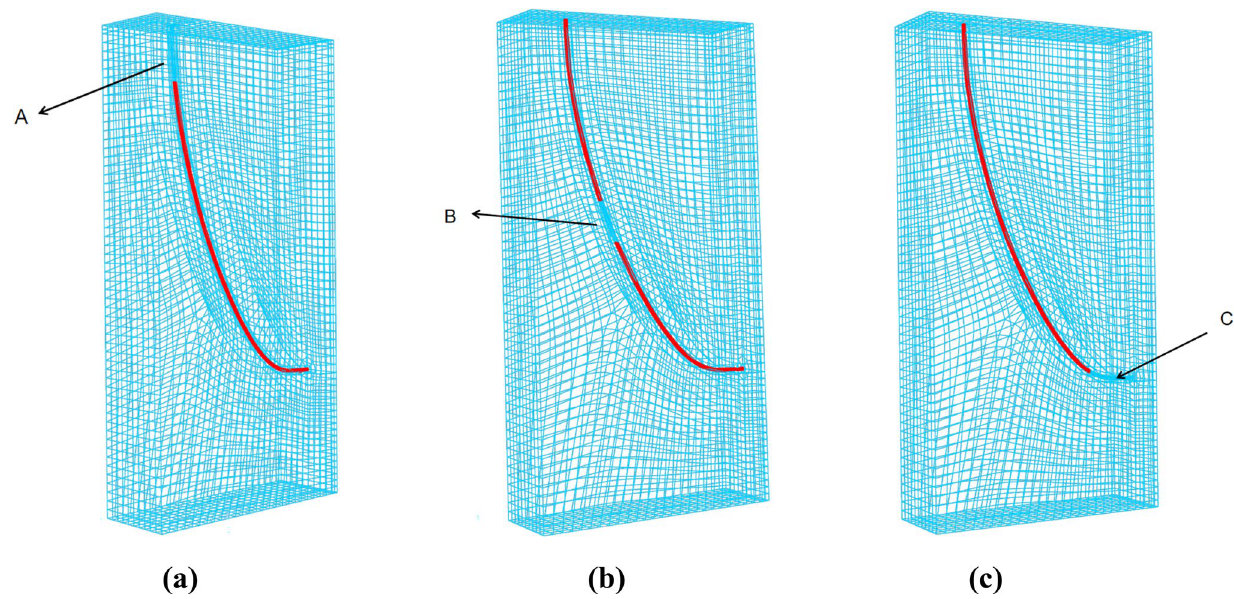
Fig. 8 Cement missing area. a Tilting area missing. b Central area missing. c Target area